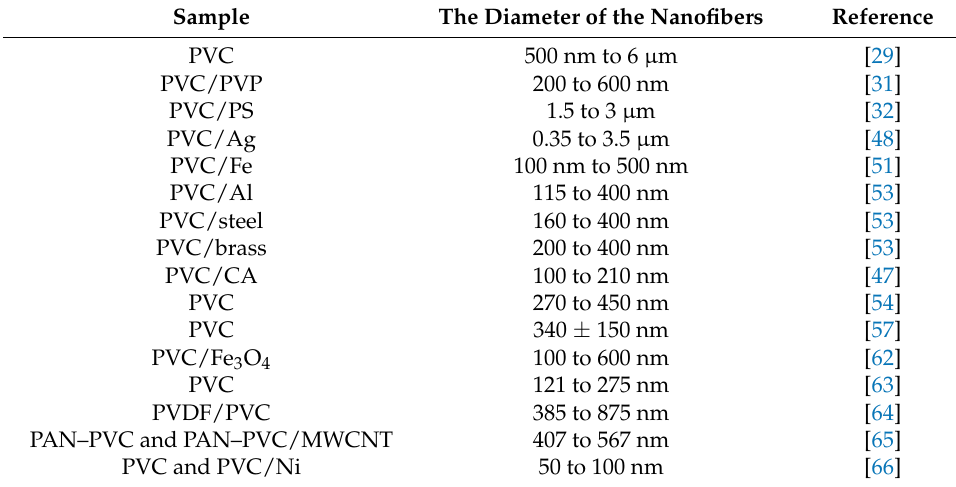
Figure 3. SEM micrographs and size distributions of electrospun PVC fibers as functions of the solvent composition. The THF/DMF volume ratios were ( A ) 100/0, ( B ) 60/40, ( C ) 40/60, and ( D ) 0/100 [29]. Table 3. Diameters of electrospun PVC